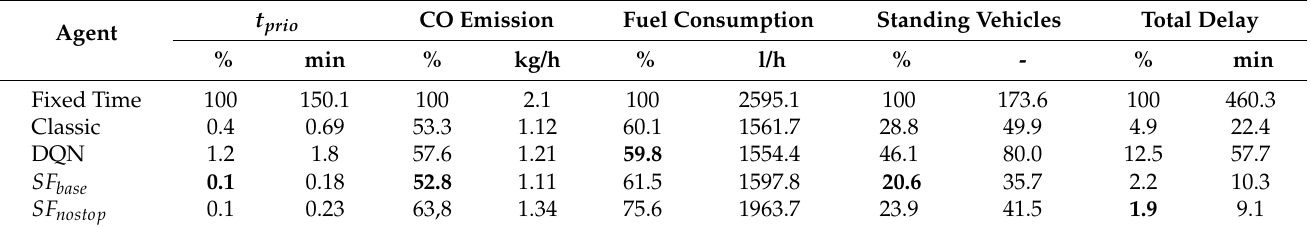
Figure 2. Comparison of classic (orange), fixed-time (yellow), DQN (green), and SF-based approaches (blue and magenta). Each boxplot refers to the average values and their distribution based on 1000 randomized scenarios with the asynchronous flow. The compared metrics are the average CO emissions, fuel consumption, total delay, and standing vehicles. The SF-based agent preferences are w base = [ 1,1,1,1,1 ] and w nostop = [ 0,0,0,1,0 ] . Table 3. Comparison of the performance between the different solutions in case of asymmetric